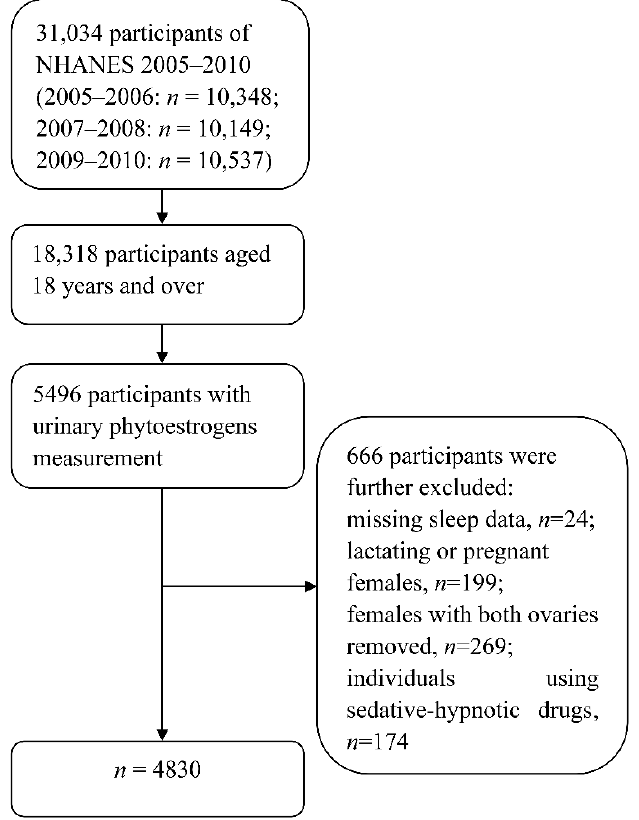
Figure 1. Flowchart of the screening process of eligible participants from the National Health and Nutrition Examination Survey 2005–2010.